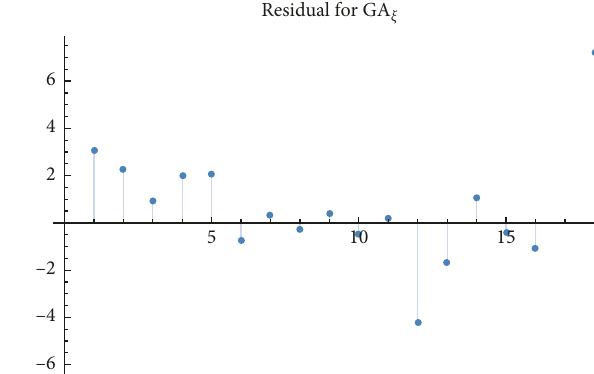
Figure 8: Plot shows the residuals for S on GA